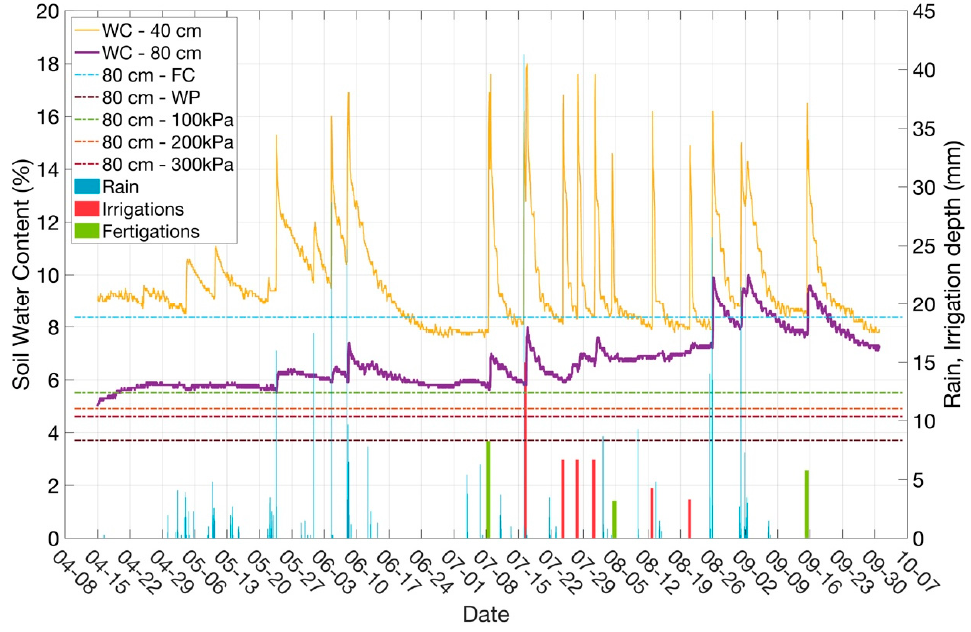
Figure 6. Soil water content measured by the WSN probes for Sector 1-2-1 in the period April–September 2018. The reported FC, WP and − 100 kPa, − 200 kPa, − 300 kPa thresholds refer to the 80 cm horizon only; irrigation, fertigation and rainfall events and are also